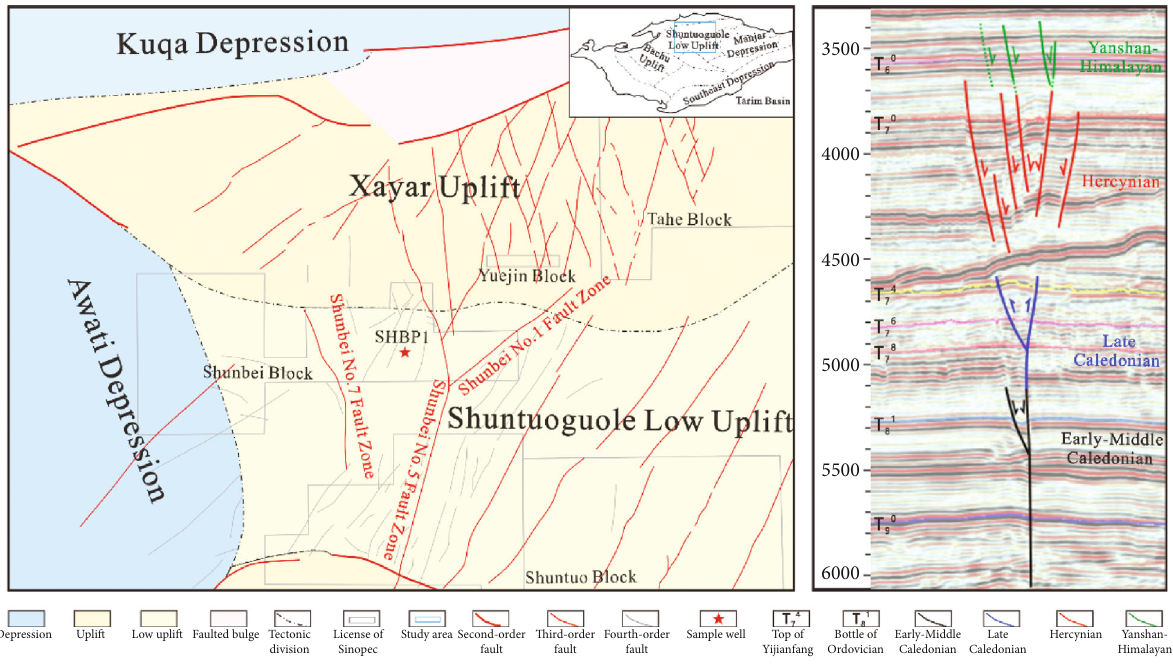
Figure 1: Tectonic location of Shunbei area in Tarim